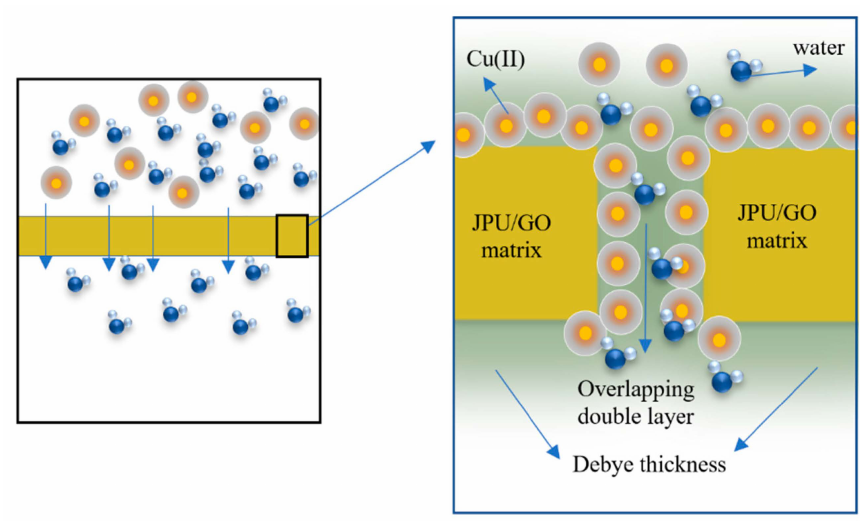
Figure 2. Proposed mechanisms for rejection of Cu(II) ions based on the charged exclusion effect within the pores JPU/GO 0.50 wt% membrane.